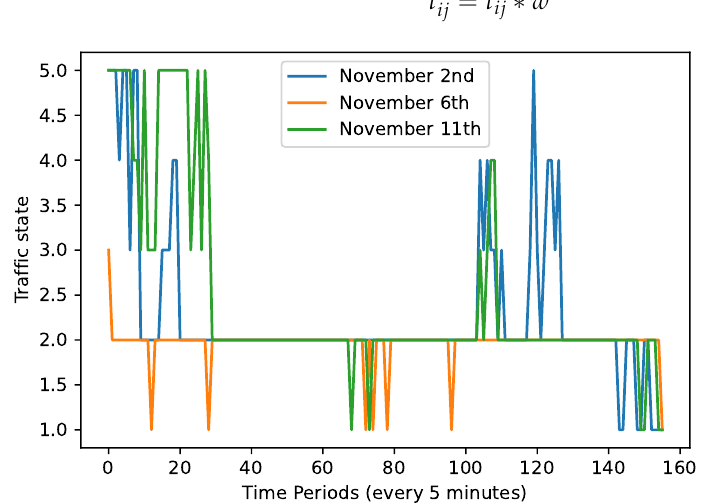
Figure 4. Traffic change in the city of Barcelona between 09 h to 21